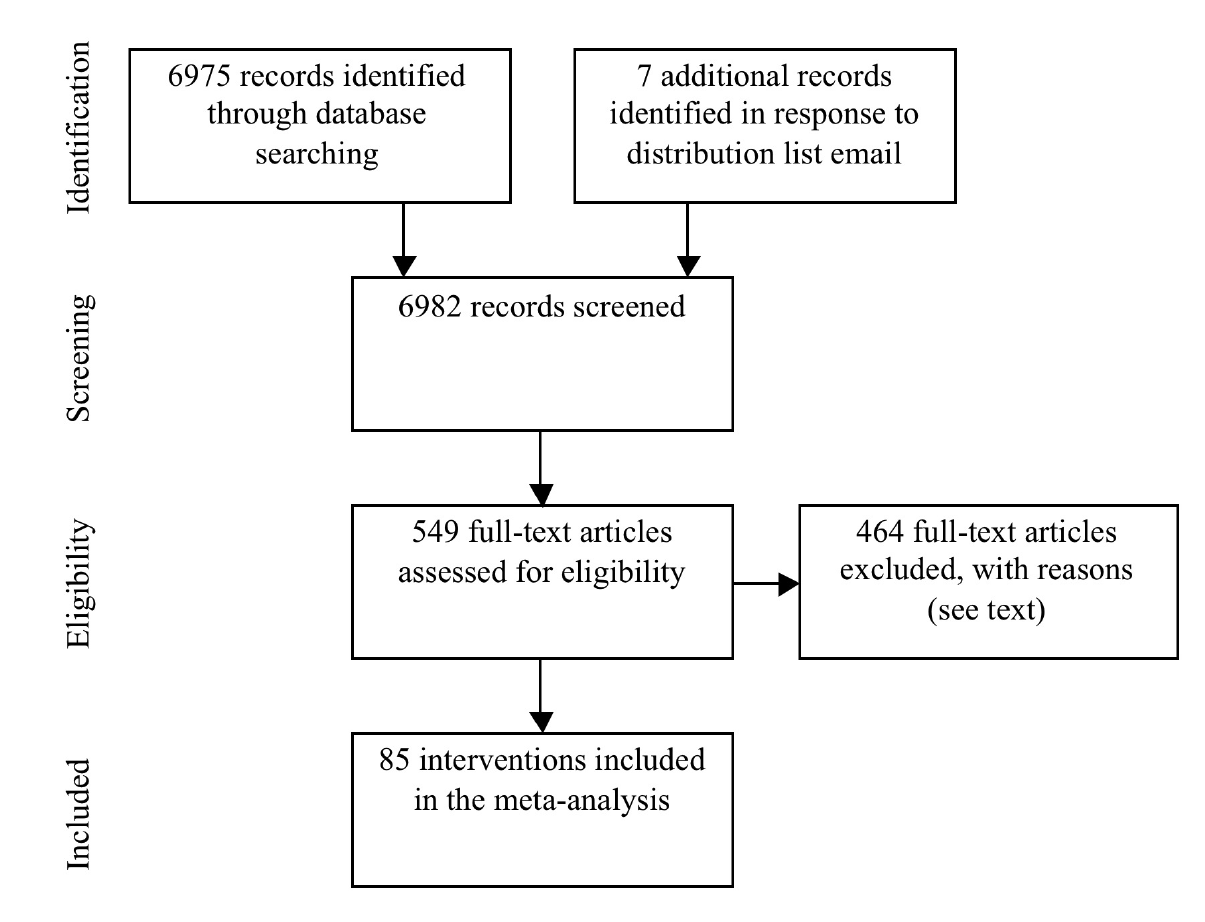
Figure 1. Flow of information through the different phases of the review (adapted from